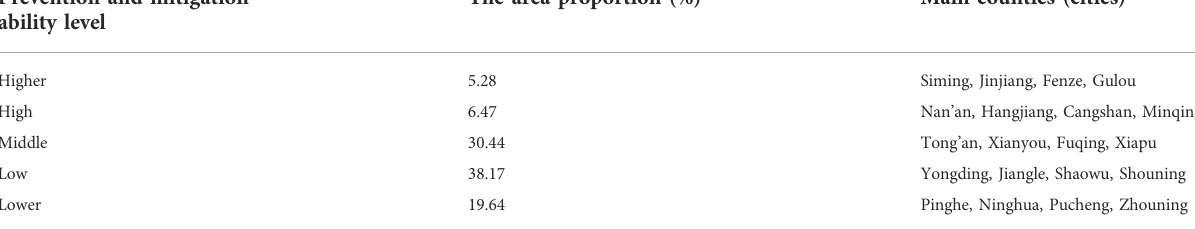
TABLE 6 Proportion of different prevention and mitigation ability levels over the whole province. Prevention and mitigation ability